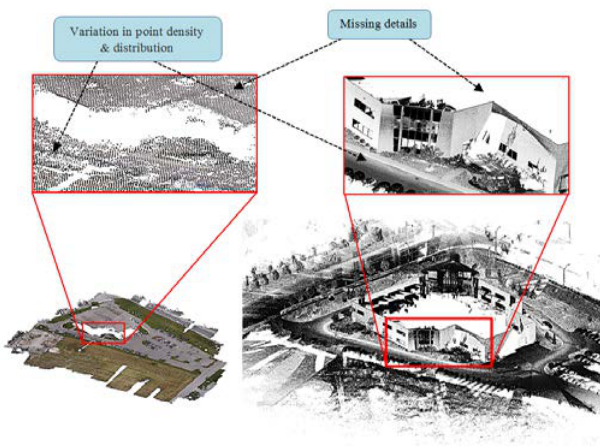
Figure 3. Example of two point cloud datasets from different sensors (left: UAV, right: Mobile laser scanner) with varying point characteristics such as different point density, point distribution and point details.